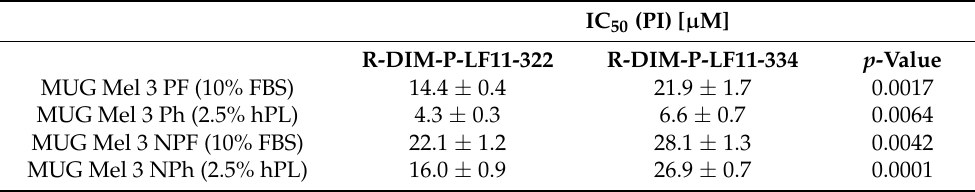
Table 3. IC 50 values [ µ M] of peptides R-DIM-P-LF11-322 and R-DIM-P-LF11-334 on all four MUG Mel3 cell lines. IC 50 ± SD [ µ M] is summarized for all MUG Mel3 cell lines cultivated in 2.5% hPL